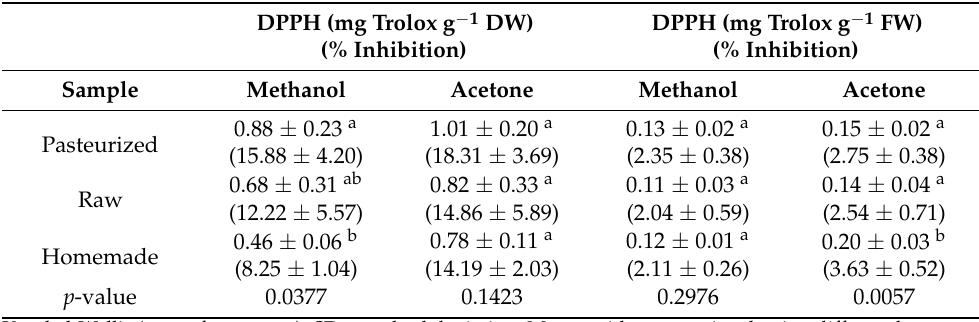
Table 3. Radical scavenging activity (expressed in mg Trolox equivalent (TE) per g freeze dried sample or per g fresh weight) of salmorejo samples (mean ±